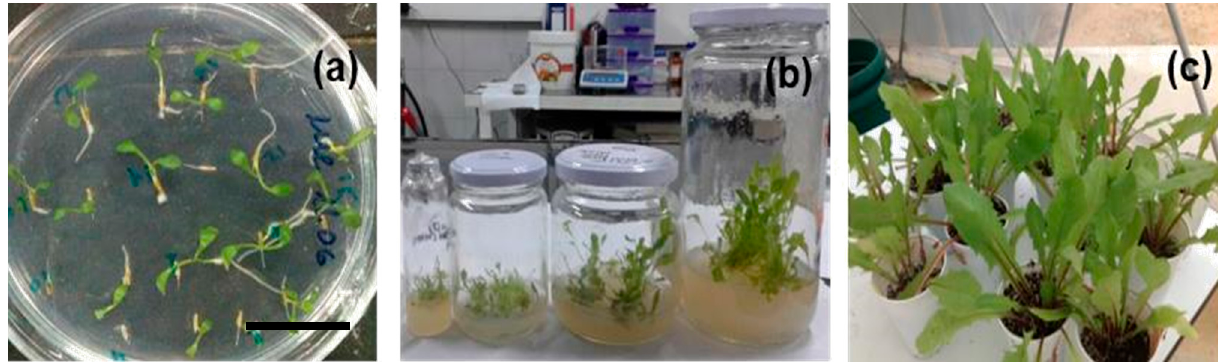
Figure 3. Seedling development of Taraxacum officinale seeds in 2.3% SUC and 0.225 mg/L NAA-3.0 mg/L BAP at ( a ) 0, ( b ) 5, ( c ) 6, ( d ) 7, ( e ) 10, ( f ) 14 and ( g ) 21 days after sowing (18/6 h light/dark, 18 ±2 °C). The size of the bars is 5 mm.